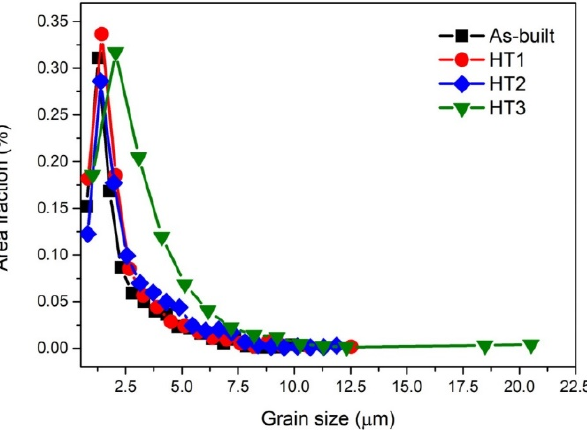
Figure 9. Grain size distribution of the samples under different heat treatment conditions.